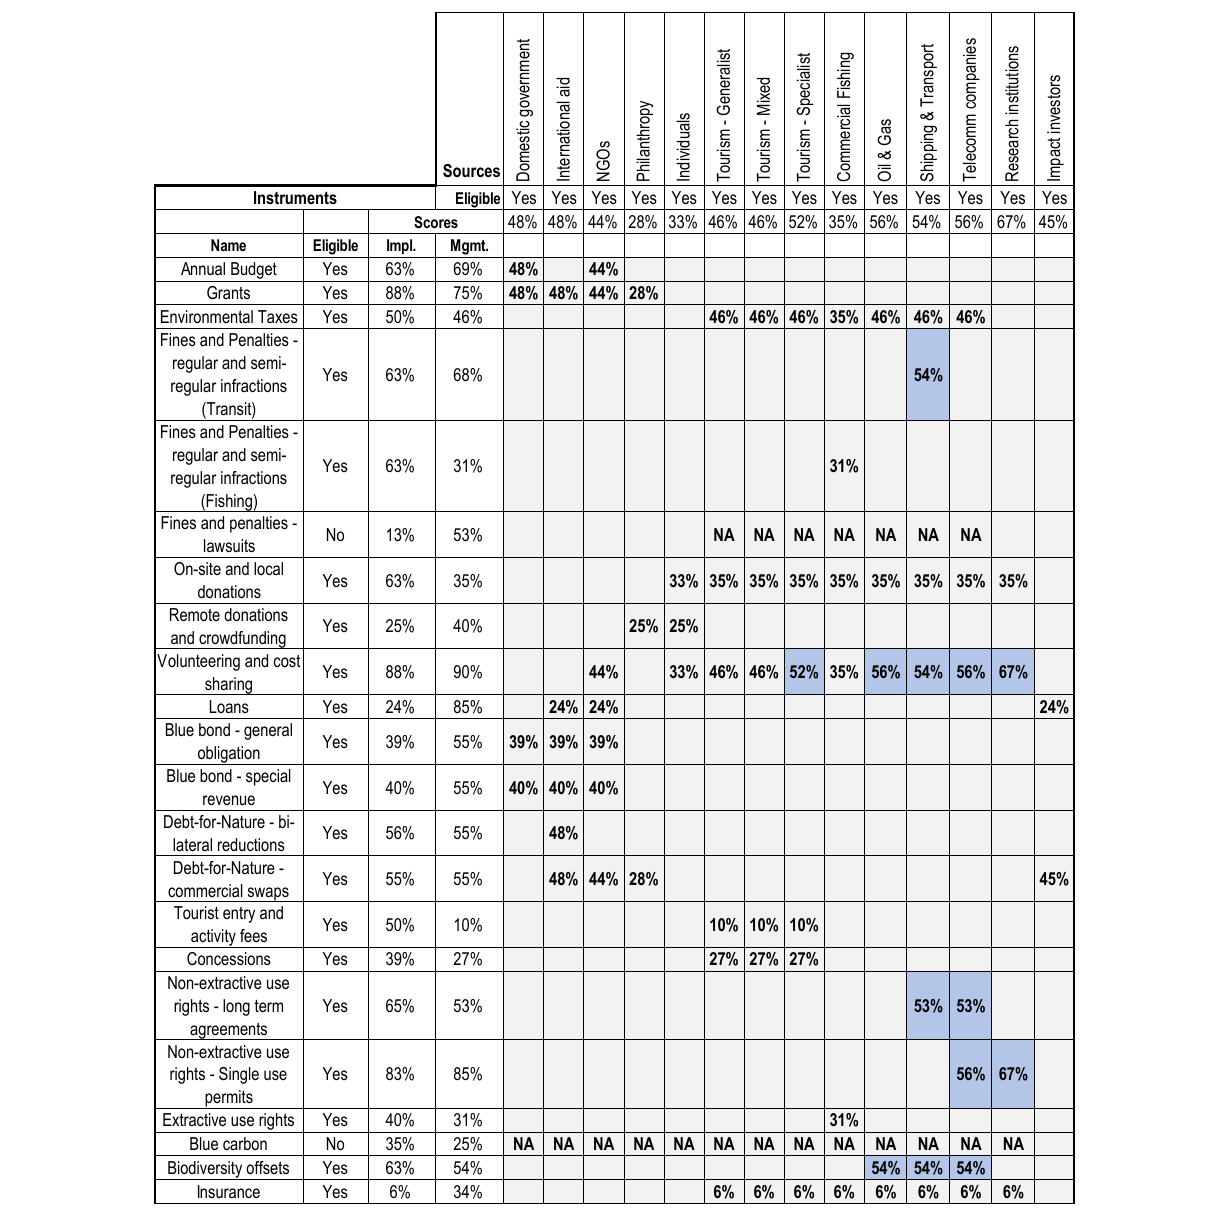
sustainability of mechanisms in the future, but are more difficult for decision makers to directly